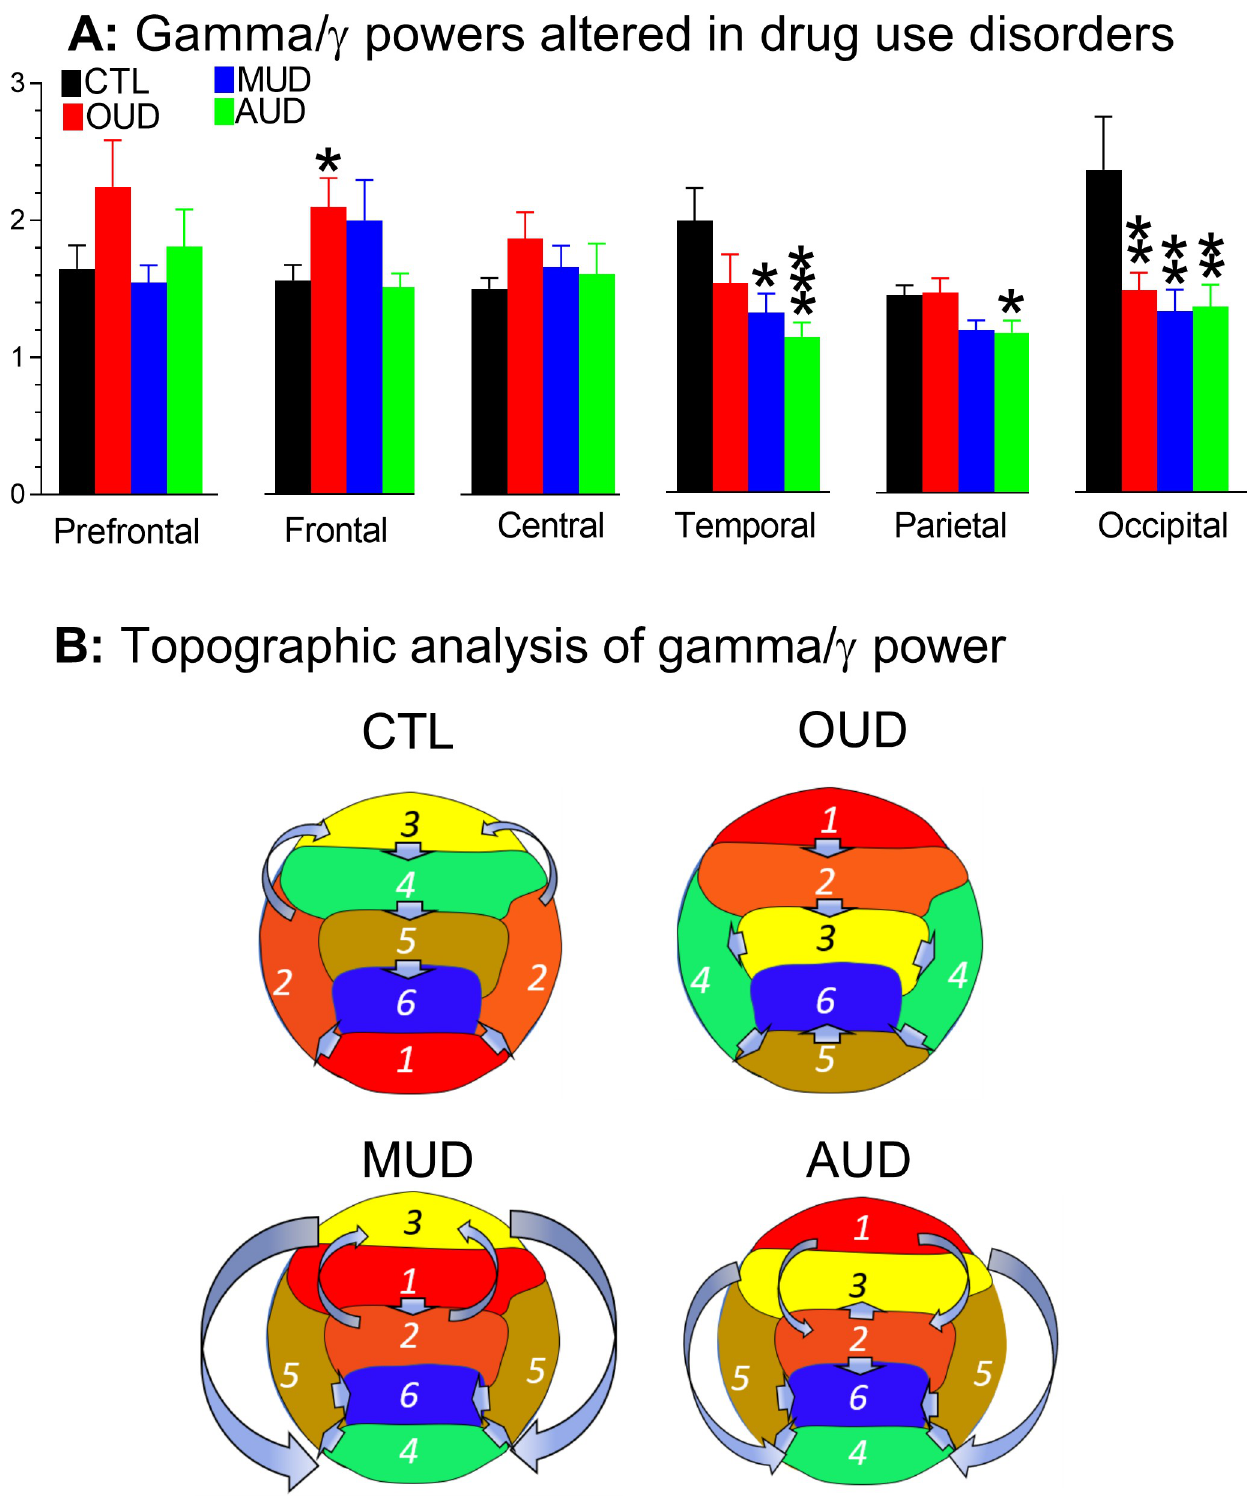
Fig 7. A , Gamma/ γ power in the cortical subregions altered in drug use disorders. � P < 0.05, �� P < 0.01, and ��� P < 0.001 vs. CTL, a post-hoc Fisher’s PLSD test followed by ANOVA. B , Topographic analysis of gamma/ γ power. Compared to the CTL, the lowest gamma/ γ power still remained at the parietal subregion while the highest power was drifted toward the prefrontal (OUD and AUD) or frontal subregion (MUD).